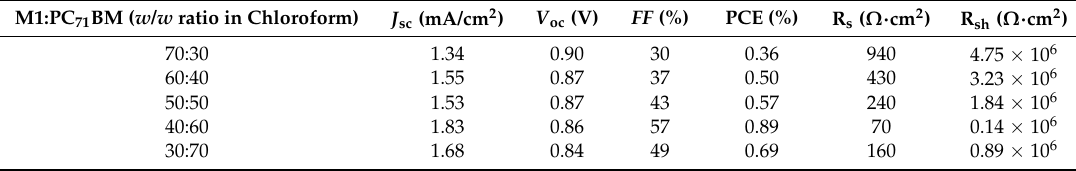
Figure 2. ( a ) Current–voltage (J-V) characteristics of BHJ solar cells based on M1 :PC 71 BM active layers with different blend ratios cast from chloroform and ( b ) J-V curves in the dark based on the different blending ratio between M1 and PC 71 BM. Table 1. Summary of device parameters for SM-BHJ (small molecule -bulk heterojunction) solar cells based on M1 :PC 71 BM active layers cast at different blend ratios from chloroform. All values are averaged from five devices with two electrodes on top of each device and a standard deviation within ±